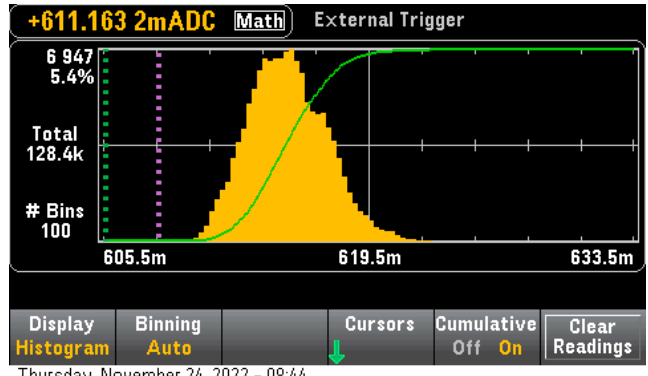
Figure 10. MobileNet-025 Inference Power consumption. Table 3. MobileNet-025 Model Results.